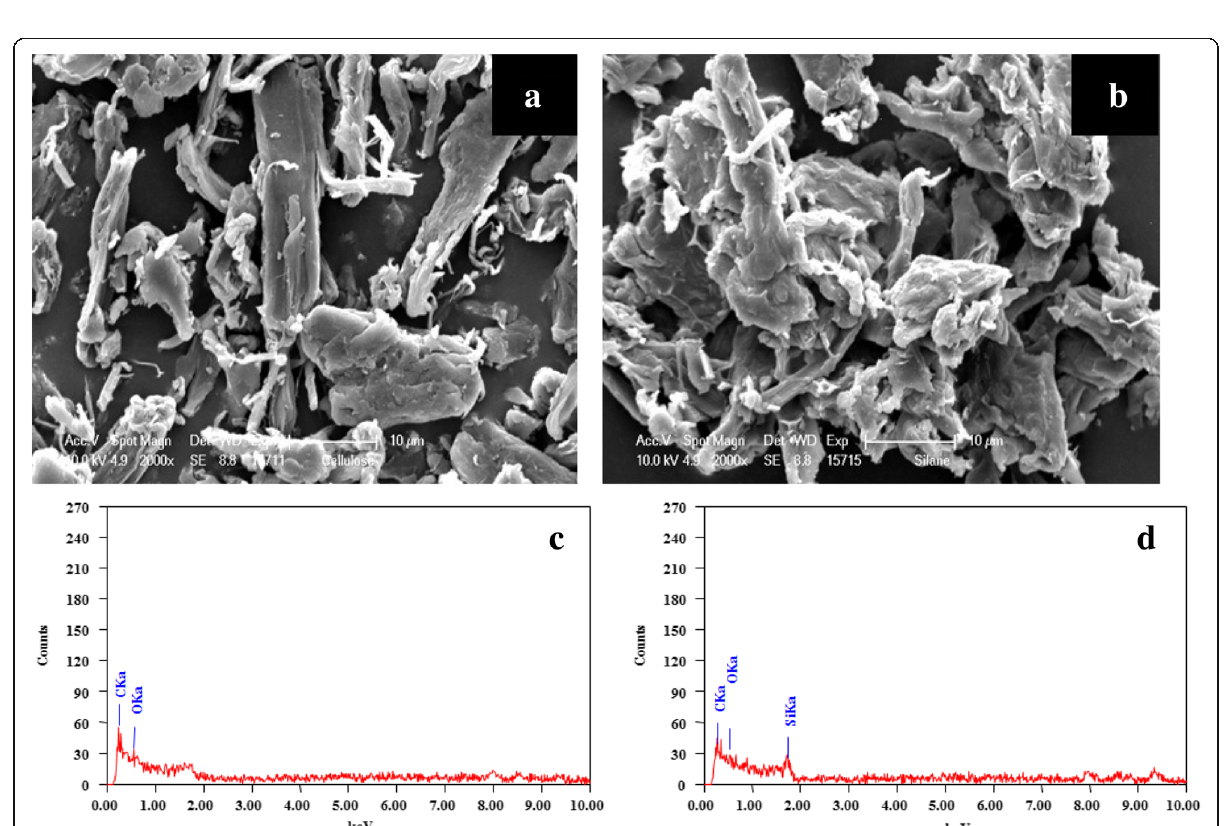
Fig. 2 SEM images of ( a ) MCC powder at magnification of 2000 X ( b ) MMCC powder at magnification of 2000 X. EDS image of ( c ) MCC powder and ( d ) MMCC